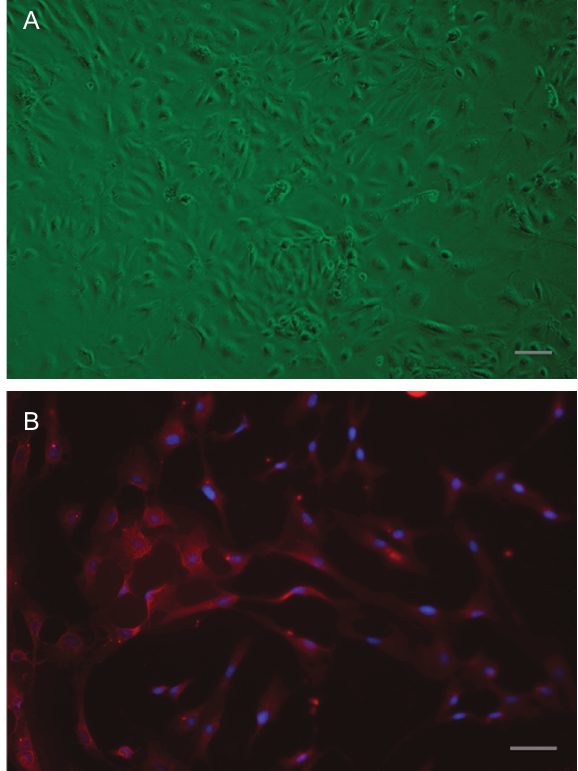
Figure 1. Light microscopy and immunohistochemical character- ization of glomerular endothelial cells (GECs). A, Phase-contrast picture of GECs in culture shows typical cobblestone appear- ance with growth in the form of islands (original magnification 100X). B, Positive (cytoplasm and membrane) staining for von Willebrand factor (original magnification 100X; bars = 100 μ m).